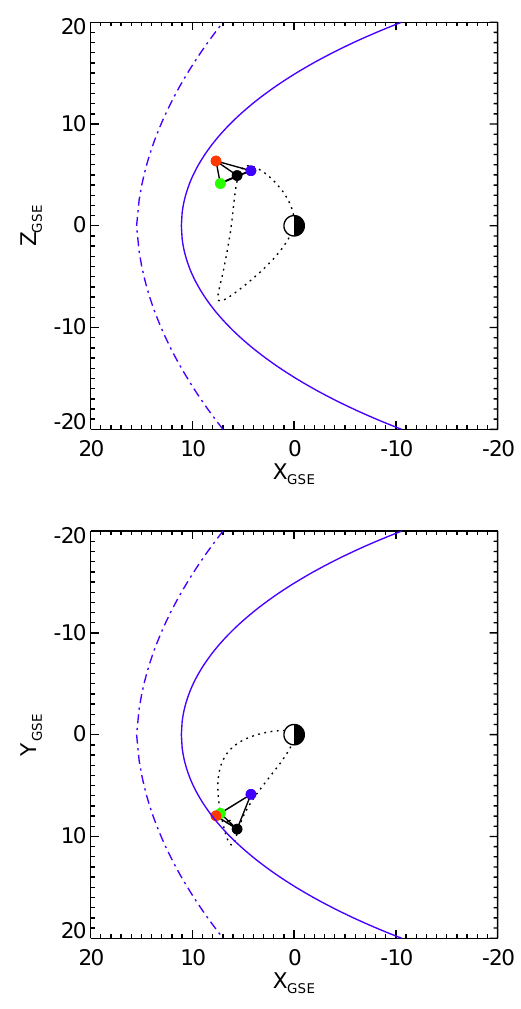
Fig. 2. The location of the Cluster spacecraft in the GSE XZ (top) and XY (bottom) planes at 19:30UT on the 27 January 2006. The location of Cluster 1 is represented by a black dot; the positions of the other three spacecraft are expanded by a factor of two with respect to Cluster 1. Clusters 2, 3 and 4 are represented by red, green and blue dots. A model bow shock and magnetopause are shown as blue dot-dash and solid lines respectively (Tsyganenko, 1995; Peredo et al., 1995). The dotted black line shows a field line from the Tsyganenko (1995) model which is traced through the lo- cation of Cluster 1. The Cluster orbit crossed the magnetopause at about 15:00h magnetic local time. Clusters 1, 2 and 3 were all relatively close to the model magnetopause, whilst Cluster 4 was situated deeper into the